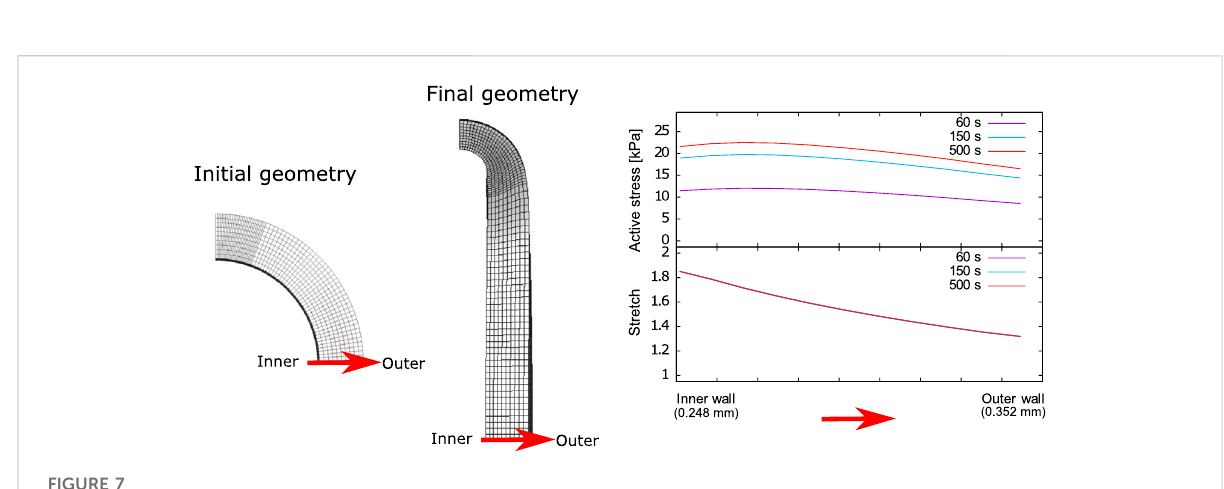
Active stress and stretch variation along the carotid artery wall